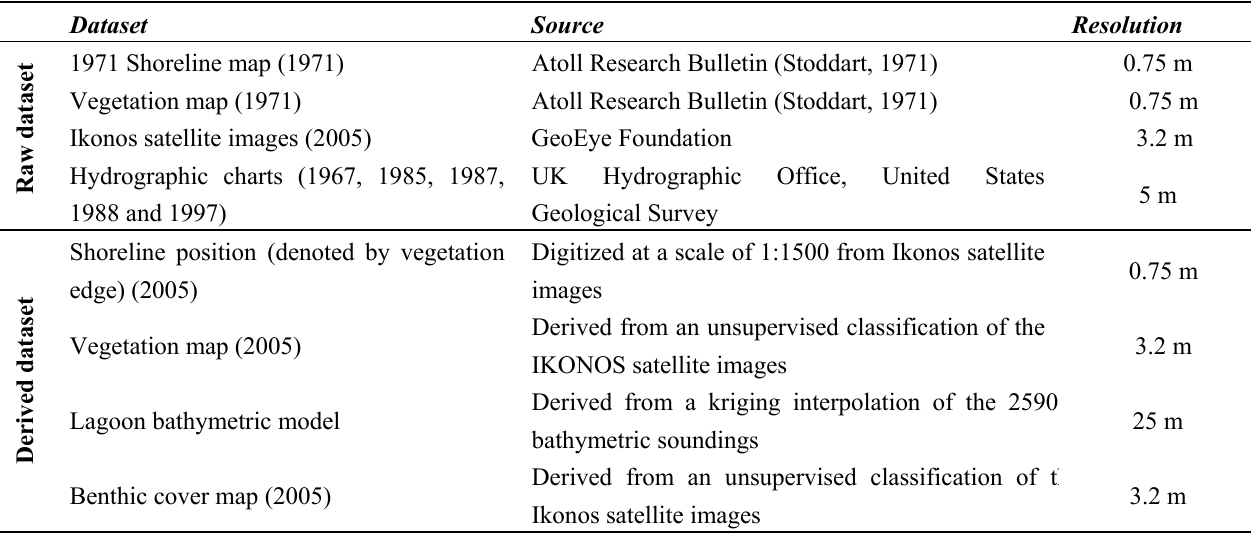
Table 1. A summary of the raw and derived datasets compiled for the assessment of ecological and geomorphic change on Diego